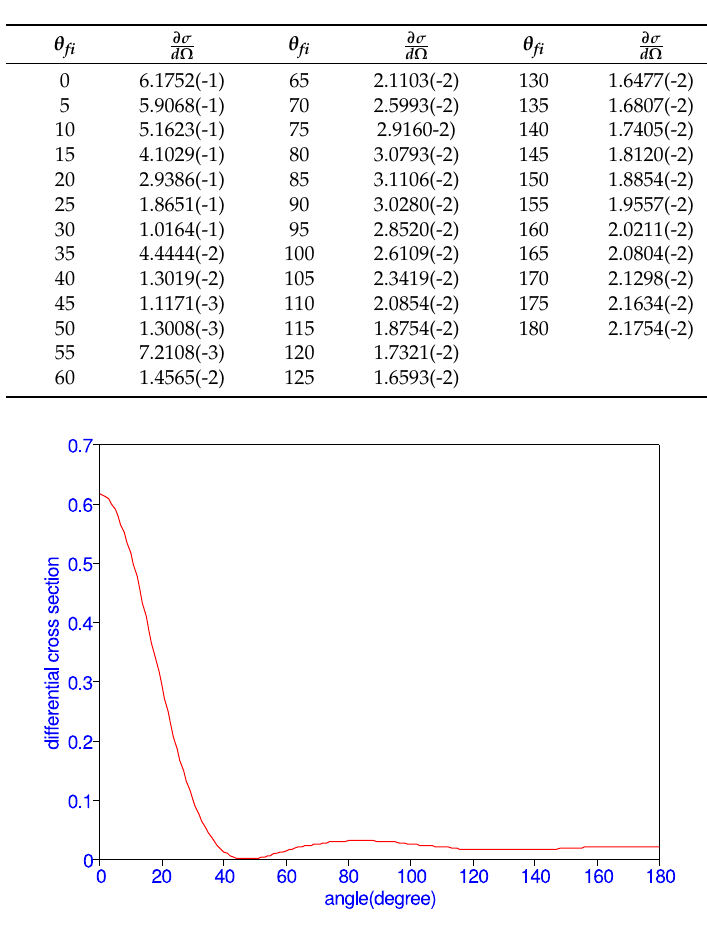
π vs. angle (degree) at k = 1.0. Figure 3. (Color online) Differential cross section ( π a 2 / sr ) vs. angle (degree) at k = 0